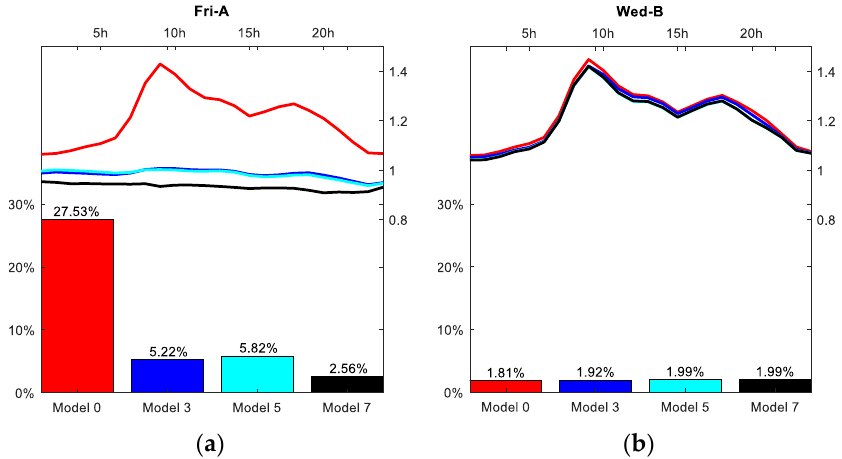
Figure 9. ( a ) MAPE for models 0, 3, 5 and 7 for Good Friday. ( b ) Coefficient profile and MAPE for models 0, 3, 5, and 7 for the Wednesday after Good Friday.